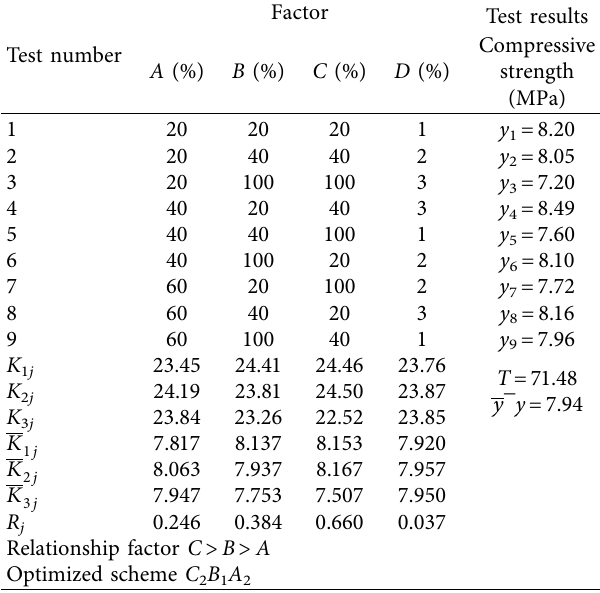
Table 3: Test results and calculation